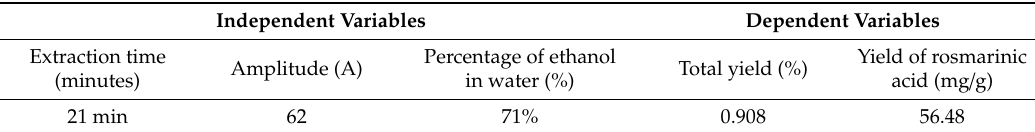
Table 3. Optimum conditions of the extraction.